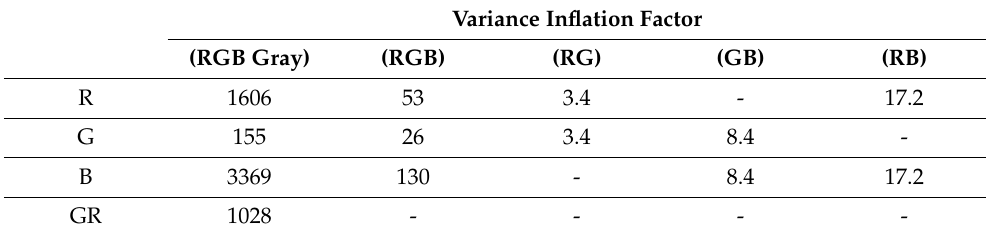
Table 2. Results of multicollinearity assessment for the developed models.